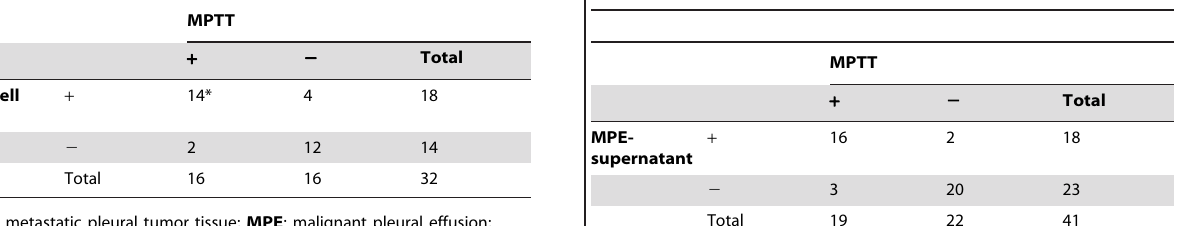
Table 4. Comparison of EGFR mutation between MPE- supernatant and matched